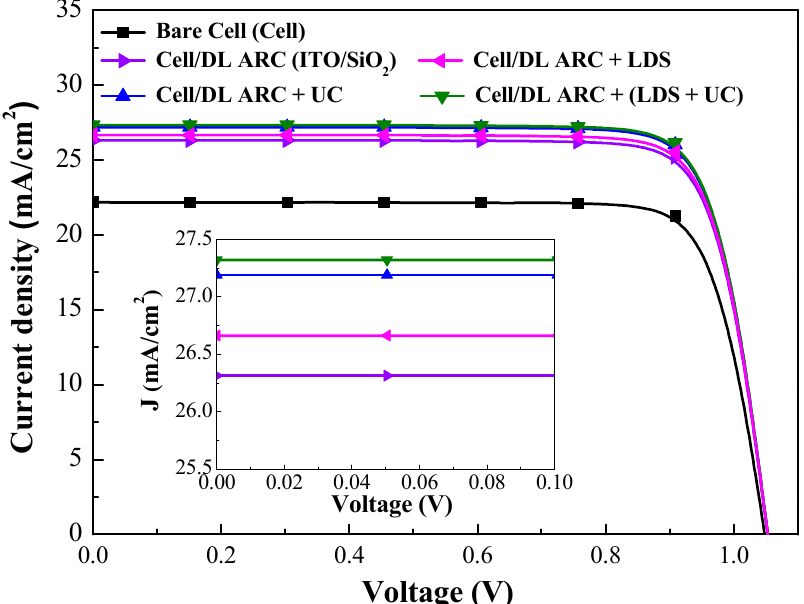
Figure 13. Photovoltaic J-V curves of bare-type GaAs single-junction solar cell (cell), cell / DL-ARC, cell / DL-ARC + LDS, cell / DL-ARC + UC, and cell / DL-ARC + (LDS + UC).